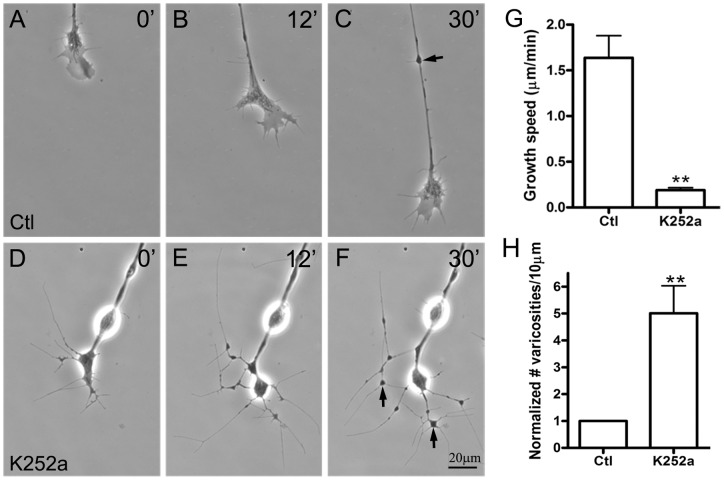
Effect of Trk inhibition on axonal growth.Spinal neurons were incubated in control medium (A–C) or medium containing 500 nM K252a (D–F). The growth speeds of axons were measured from images taken during time-lapse recordings. Treatment with K252a led to a significant reduction in axonal growth speed (G) and also to the elaboration of the distal end of the axon into a web of interconnecting neurites and varicosities within 30 min. Although varicosities were also observed along control axons and were often associated with filopodia (arrow in C), they were much more numerous within the distal neuritic web generated after K252a treatment (arrows in F and quantified in H). Mean and SEM shown; t test: **p<0.01, compared with untreated Ctl.